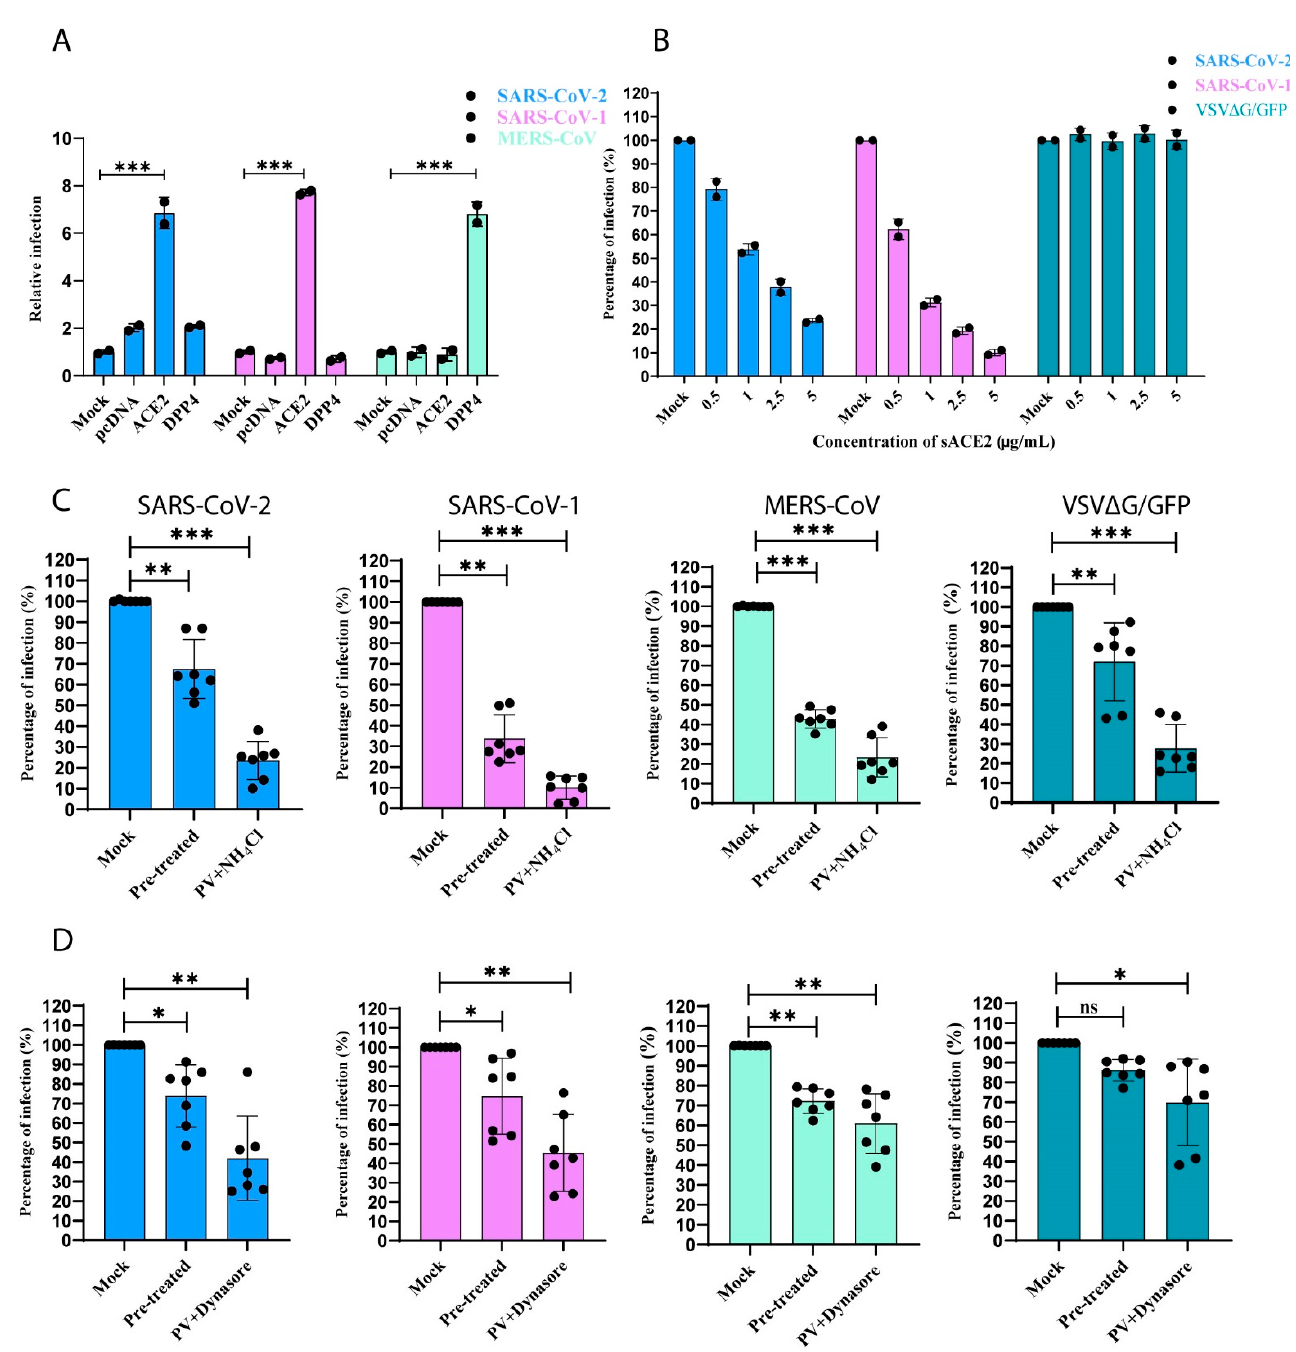
Figure 6. Receptor-mediated endocytosis of pseudotyped CoVs. ( A ) BHK21 cells expressing either ACE2, DPP4, or pcDNA were infected with SARS-CoV-1 and -2 PVs, MERS-CoV-PV, and VSV ∆ G/GFP. After 24 h, percentage of CoV-PVs infections were quantified by counting the number of GFP-positive cells. ( B ) SARS-CoV-1, -2, and VSV ∆ G/GFP were pre-incubated with varying concentrations of sACE2 (0.5 to 5 µ g/mL) for 1 h prior to the infection on Vero E6 cells. After 24 h infection, cells expressing GFP were counted and the percentage of infection calculated. ( C ) Monolayer of Vero E6 cells were treated with either ( C ) 20 mM of NH 4 Cl or ( D ) 100 µ M Dynasore 1 h prior (pre-treated) to the infection of PVs or either of the compounds were added to the cells during infection, followed by 1 h pre-treatment. The percentage of infection was calculated by counting the number of GFP-positive cells. Mock in each condition refers to untreated/non-transfected cells. The graphs represent data from at least three independent experiments. Data are shown as mean ± SD. p -value was determined by one-way ANOVA analysis (* p < 0.05; ** p < 0.01; *** p < 0.001).